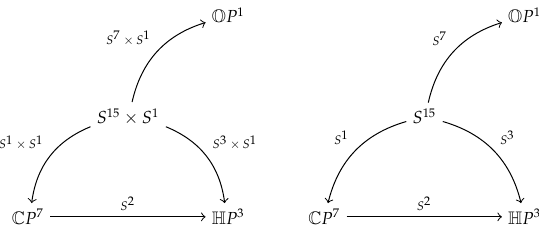
Figure 2. In the octonionic case, an additional fibration